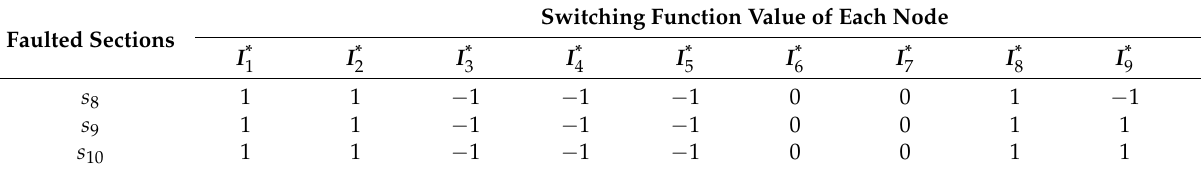
Table 4. Solution result of switch function.